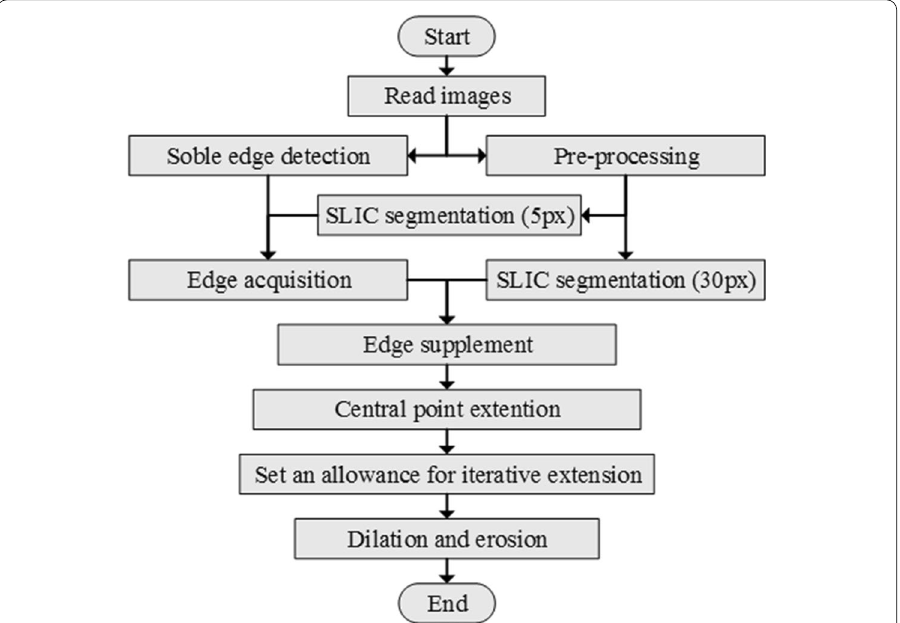
Fig. 3 Operational processes of extracting the yaks’ foreground